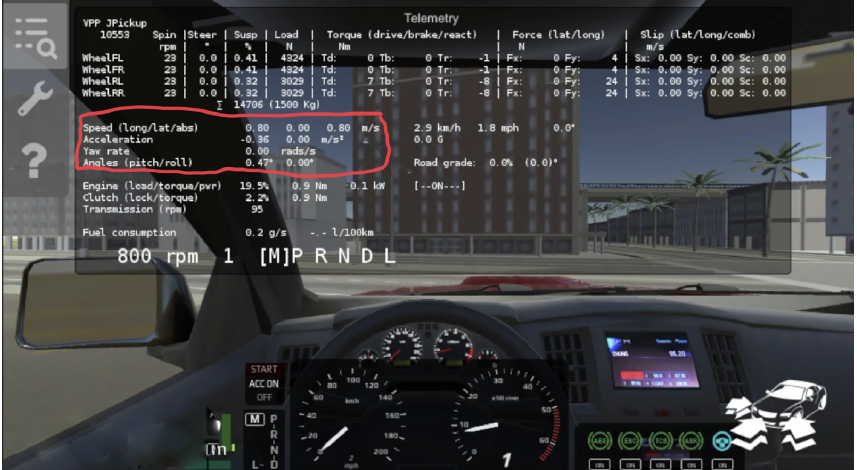
Figure 4. Vehicle Physics simulator. In the red box, the data that we collected during the